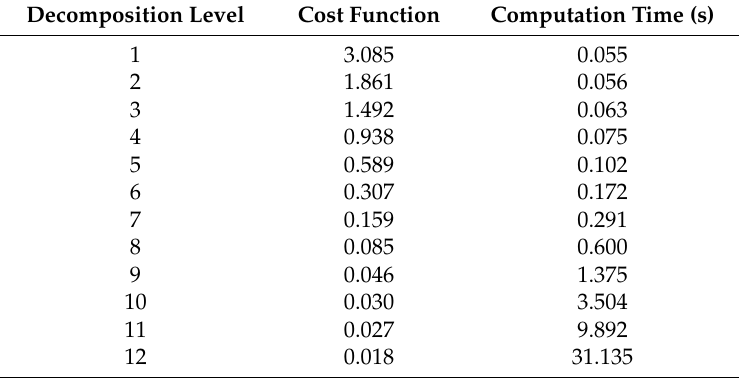
Table 1. The cost function and the computation time of different decomposition levels with the db40 wavelet.